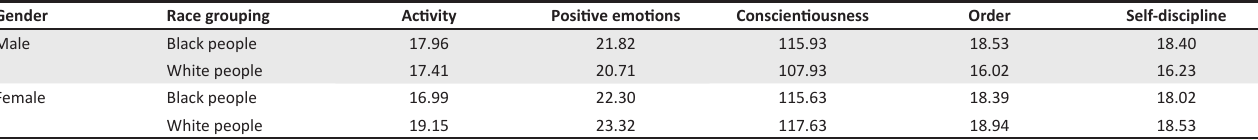
TABLE 4: Post hoc test results from two-way ANOVAs with gender and race groupings on the